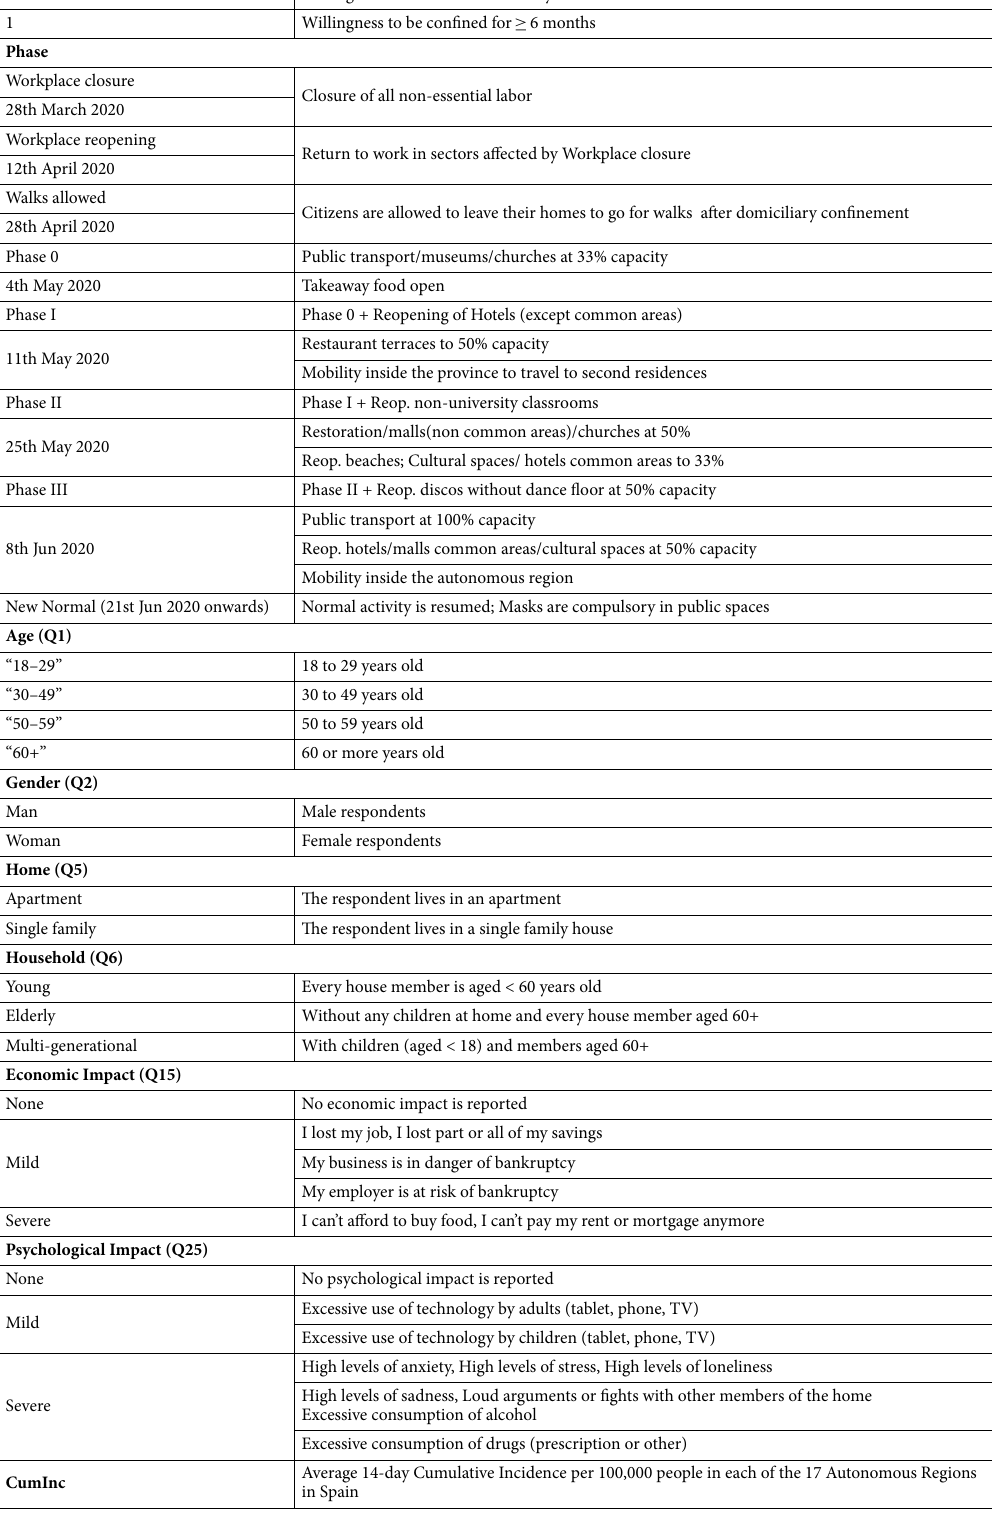
Table 1. Independent and dependent variables used in our